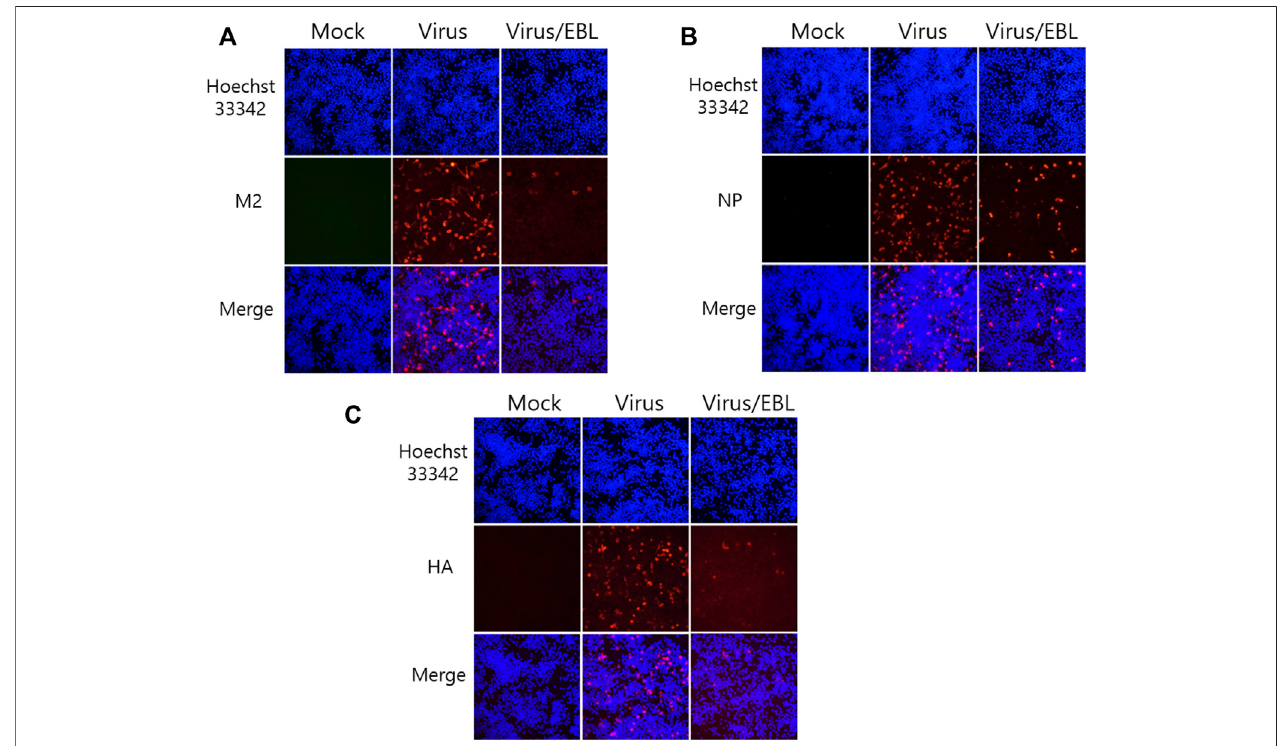
FIGURE3| Repressive effect ofEBL on in fl uenza A/PR/8/34-GFP viralprotein expression. EBLat 200 μ g/ml or medium (mock) and PR8-GFPIAV werecotreated totheRAW264.7cells.At24 hpostinfection,thecellswere fi xedwithparaformaldehyde,stainedwithantibodiesagainst (A) M2, (B) NP, (C) HA(red),andwithHoechst 33342 for nuclei (Blue). The co-localization of viral proteins and nuclei was observed under a fl uorescent microscope.